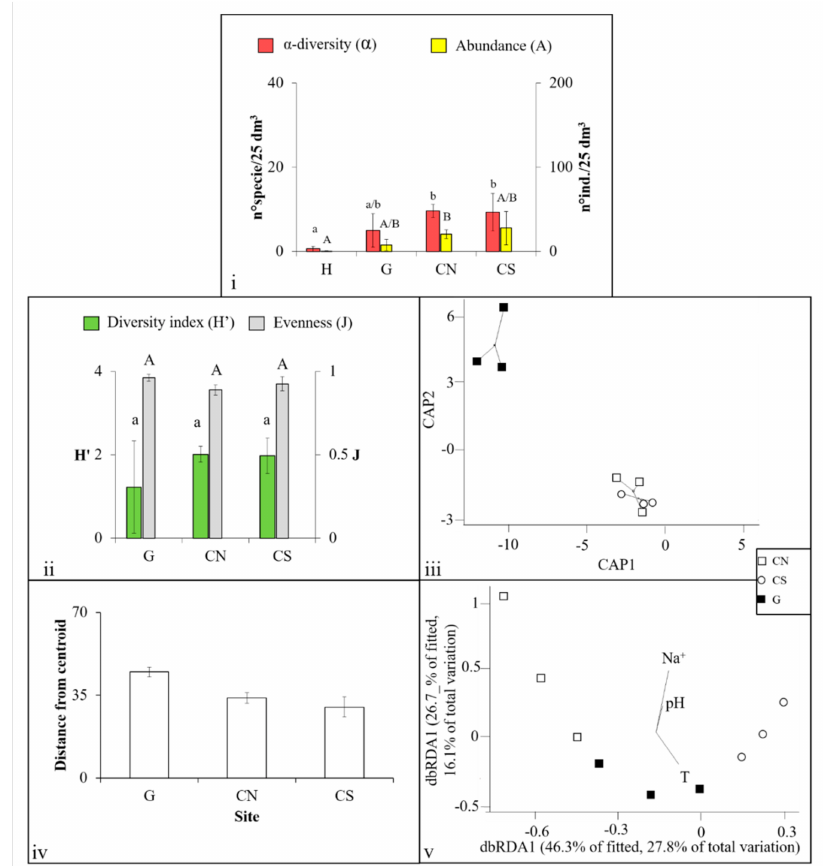
Figure 6. ( i ) α -diversity ( α ) and abundances (A) trends of Crustacea assemblages, ( ii ) diversity (H’) and evenness (J) indices trends of Crustacea assemblages. Bars with different letters (a, b or A, B) are related to sites showingsignificantdi ff erences( p < 0.05). ( iii )CAPforthefactorSite: straightlinesarerelatedtodistances of each site replicates from their cluster centroid, formally explained in ( iv ): mean ( ± SE) multivariate dispersion(PERMDISP,small-scaleheterogeneities)ofthe Crustacea assemblagescalculateontheirabundances. ( v ) The dbRDA (distance-based redundancy analysis) ordination for Crustacea heterogeneities vs. the significant explanatory environmental variables. Vector overlays represent multiple partial correlations of the explanatory variables with the dbRDA axes. See text for further